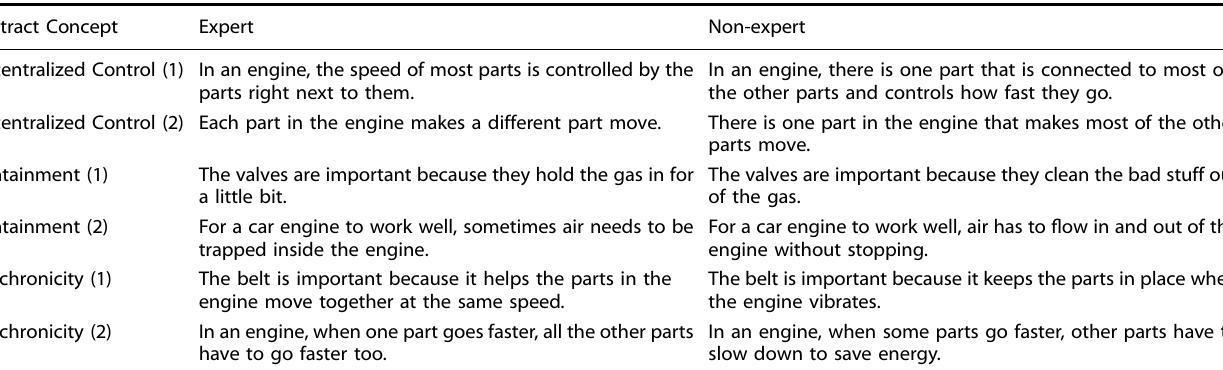
Table 1. Expert detection task